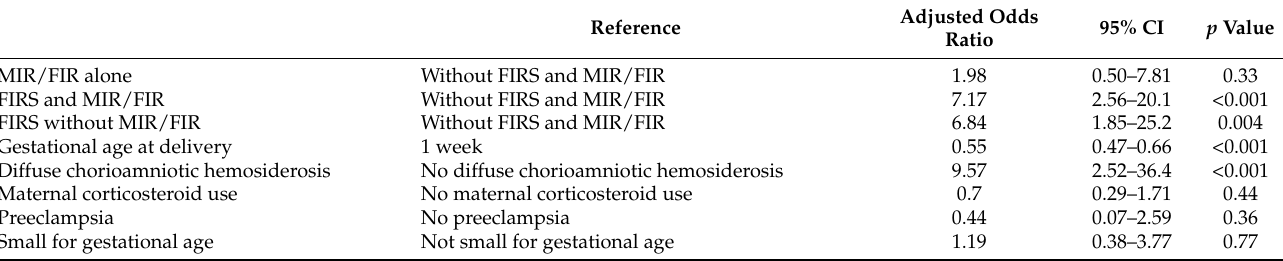
Table 5. Multivariate logistic regression analysis of the presence of adverse neonatal